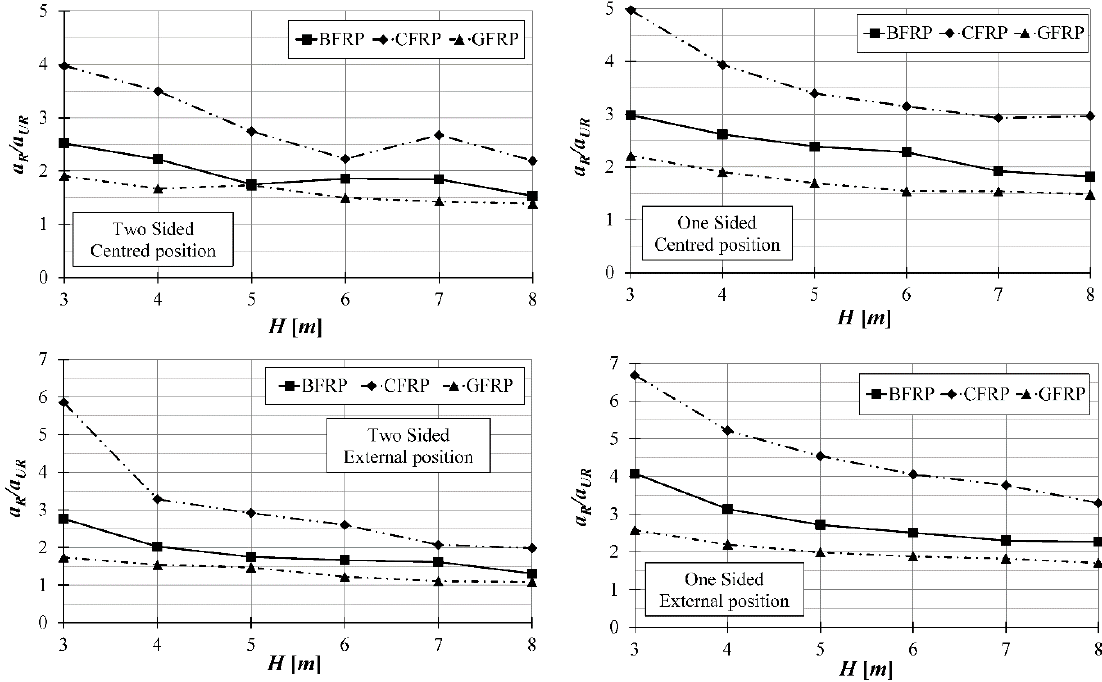
Figure 16. Level of seismic improvement varying composite material— α =7.5°, ρ =1‰, Spectrum A2.